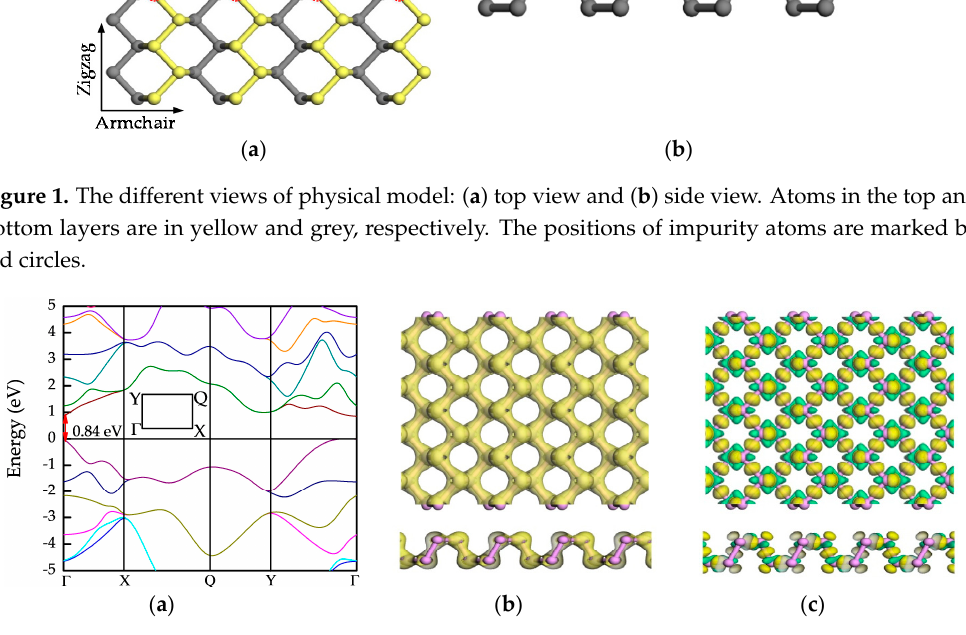
Figure 2. The electronic properties of pristine black phosphorene: ( a ) band structure, ( b ) electron density (ED), and ( c ) electron differential density (EDD). The purple ball represents phosphorus (P) atom. The isosurface in ED is 0.6 e/Å 3 , while that in EDD is ± 0.05 e/Å 3 . In EDD, yellow and green represent electron accumulation and electron depletion, respectively.